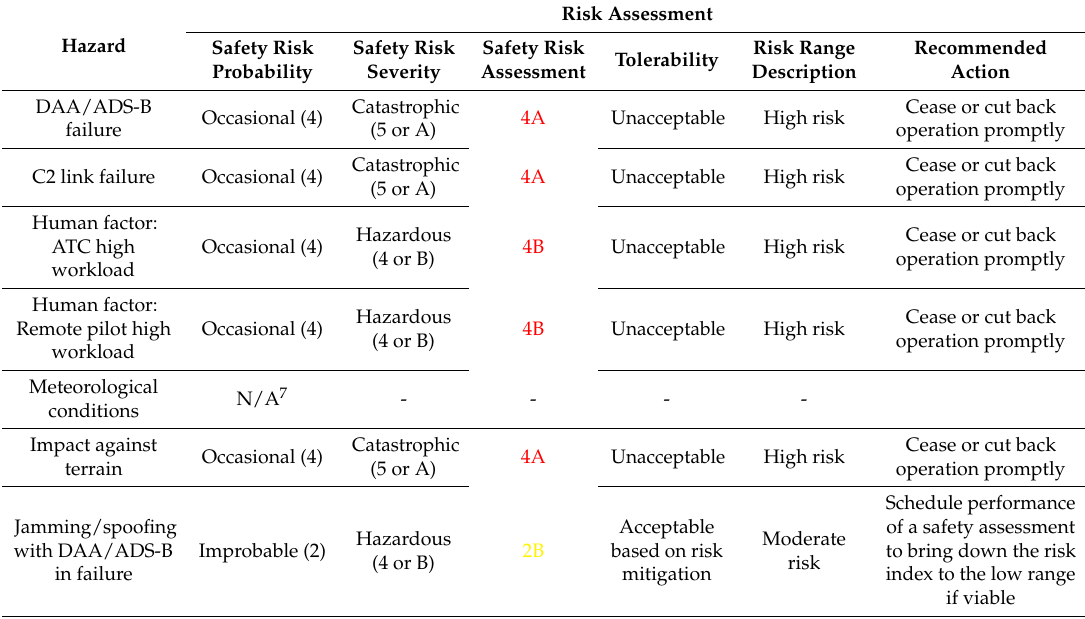
Table 7. RAID demo project flight test activity results: A safety risk identification and